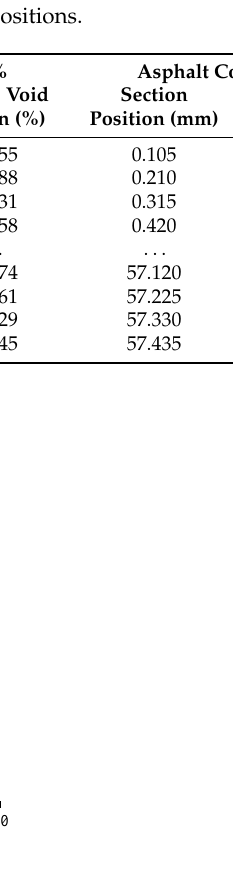
Figure 6. Surface void fraction distribution trend of EPA-13 vertical section position.